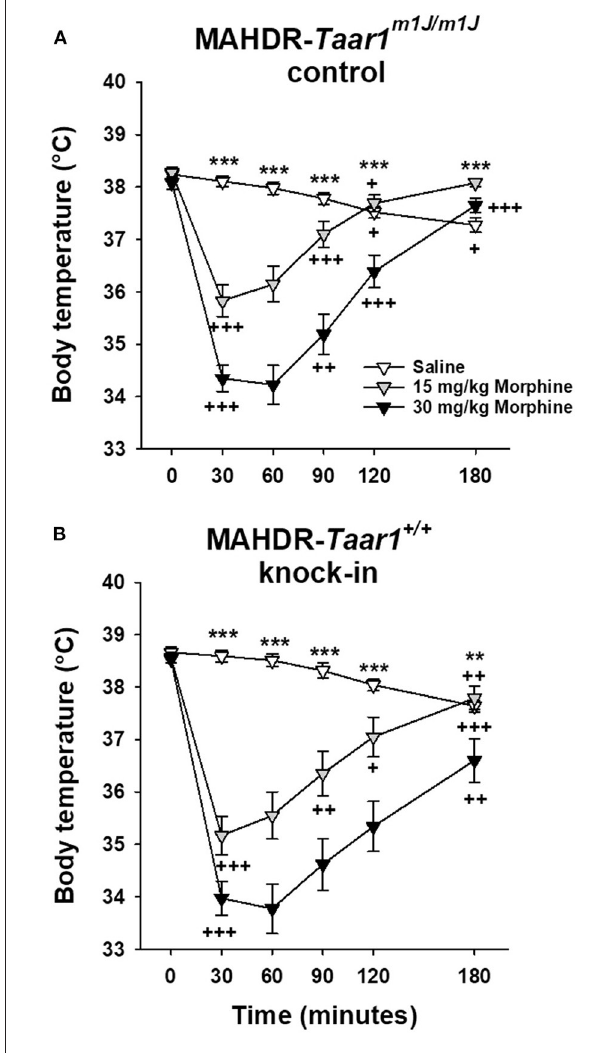
FIGURE 9 | MAHDR- Taar1 + / + KI and MAHDR- Taar1 m 1 J / m 1 J control mice, exhibited comparable sensitivity to morphine-induced hypothermia. Shown are means ± SEM for core body temperature ( ◦ C) for (A) MAHDR- Taar1 m 1 J / m 1 J control and (B) MAHDR- Taar1 + / + KI mice. A baseline temperature was obtained (T0), mice were treated IP with saline, 15 or 30 mg/kg morphine, and then rectal temperatures were obtained periodically from T30 to T180. Total N = 140 mice (11 saline-treated MAHDR- Taar1 + / + KI per sex; 12, 15 mg/kg morphine-treated MAHDR- Taar1 + / + KI per sex; 11 male and 12 female 30 mg/kg morphine-treated MAHDR- Taar1 + / + KI; 12 MAHDR- Taar1 m 1 J / m 1 J control mice per dose per sex). ** p < 0.01; *** p < 0.001 for the effect of treatment; + p < 0.05, ++ p < 0.01, +++ p < 0.001 for the change in